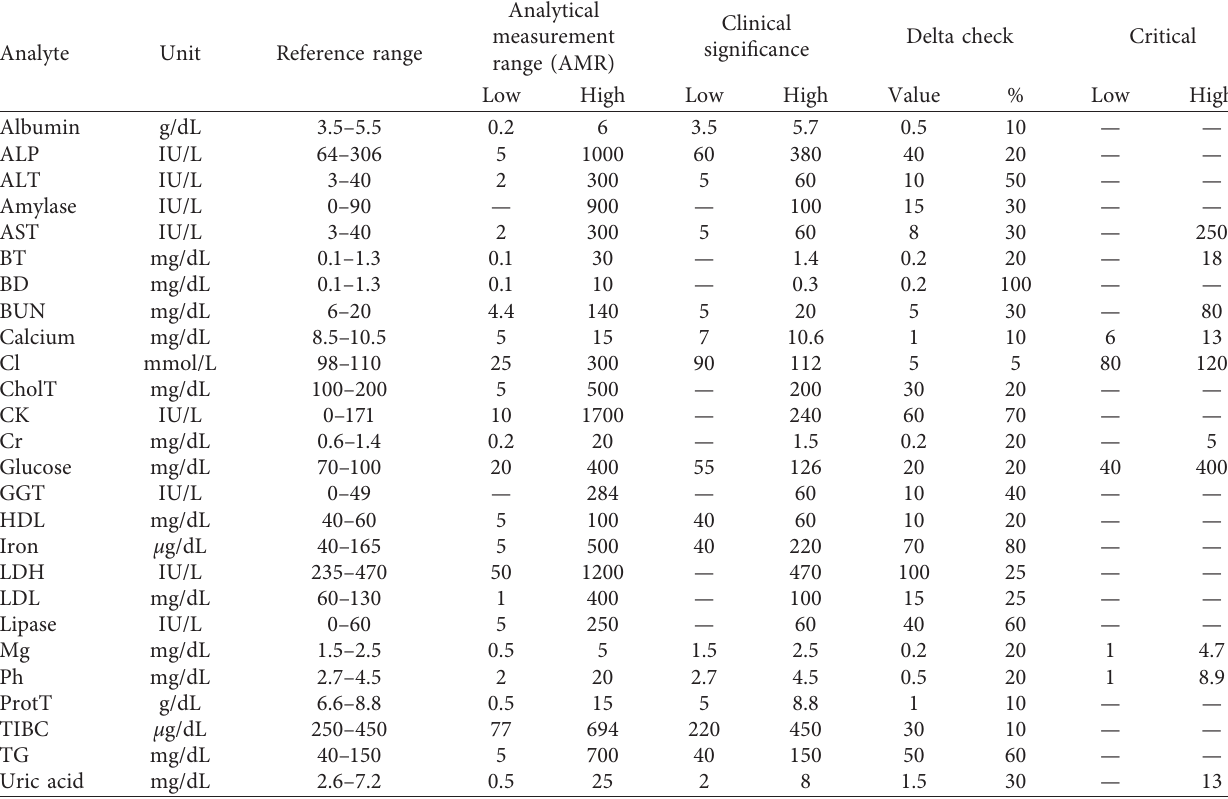
Table 2: The suggested protocol for repeat testing in our clinical chemistry laboratory.